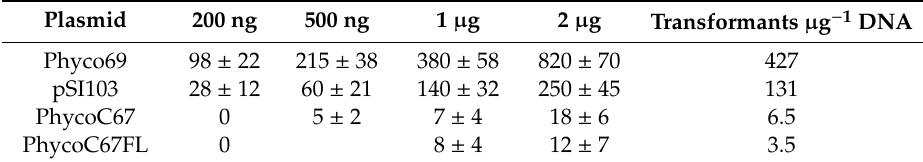
Table 1. Transformation e ffi ciency of Chlamydomonas reinhardtii with increasing quantities of the indicated plasmids. All values are the average of between three and five repetitions ± SD. The mean number of transformants µ g − 1 of DNA is also